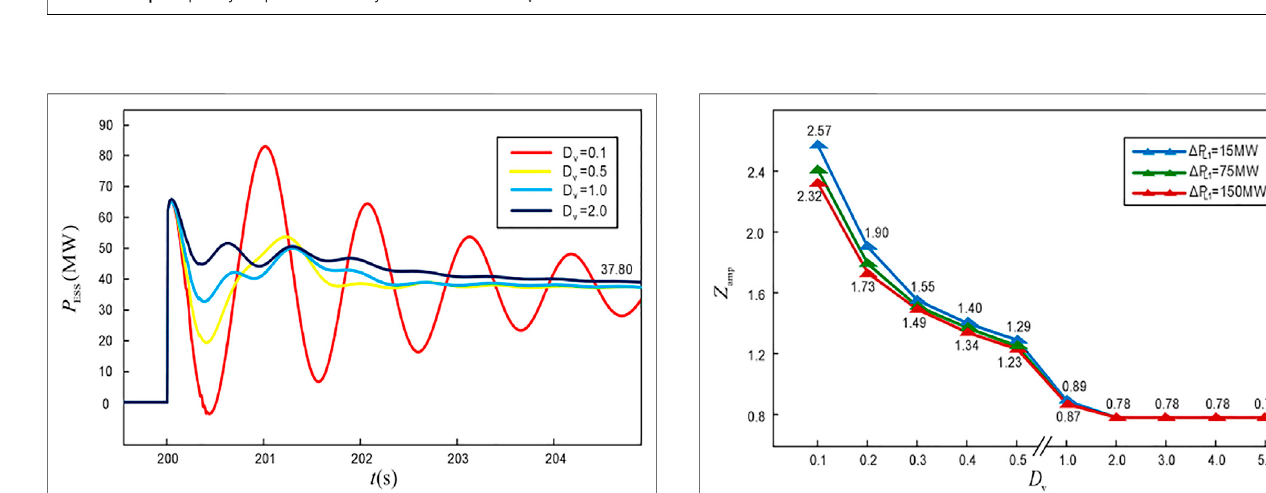
FIGURE 7 | Frequency response of the system for different D v .